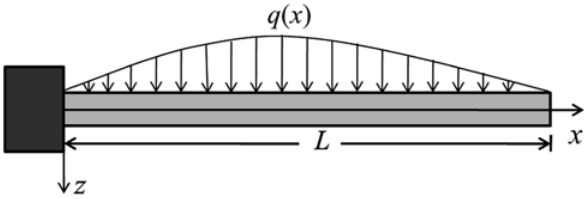
Figure 1: Cantilever gradient piezoelectric beam loaded by distrib- uted